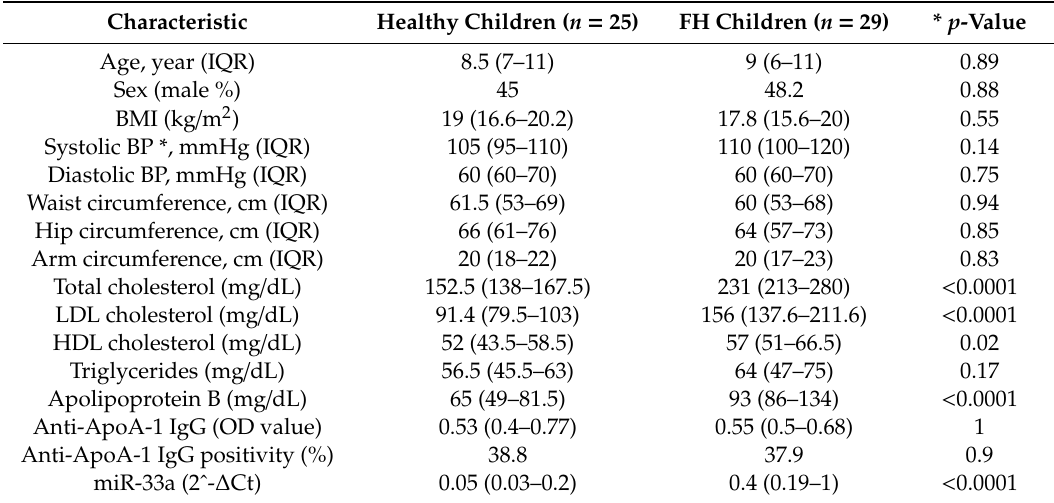
Table 1. Baseline demographic and biological characteristics of subjects according to familial hypercholesterolemia (FH)